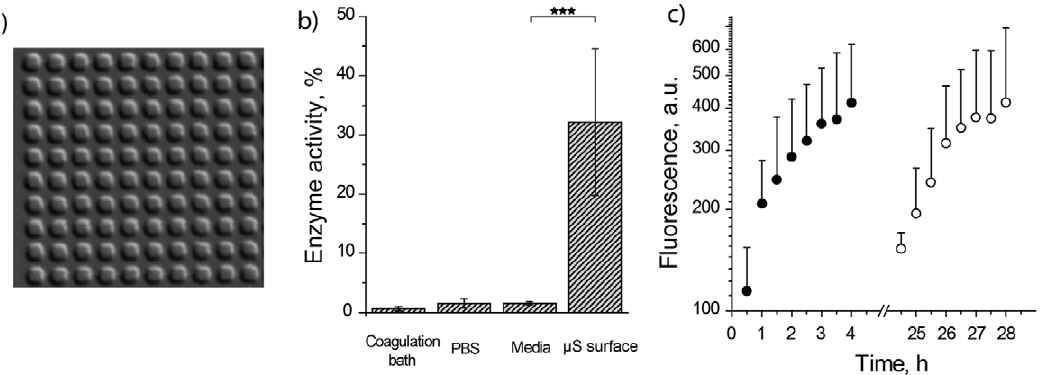
Figure 2. Visualization and initial characterization of m S PVA hydrogels as matrices for SMEPT. (a) Differential interference contrast microscopy image of the surface adhered m S PVA hydrogels (2 m m cubic structures). (b) Levels of b -Glu enzymatic activity revealed by polymer coagulation bath, PBS washing solution, cell culture media washing solution, and final surface adhered m S PVA hydrogels. Enzyme quantification was performed using FdG, 30 min reaction time and a standard curve obtained for the activity of b -Glu in PBS. (C) Experimental data for conversion of FdG into fluorescent product using m S PVA hydrogels and initiating conversion via administration of FdG at time points t=0 (solid circles) and t=24 h (open circles). Experimental conditions: [FdG]: 2,5 m g/mL; 1 g/L b -Glu in the polymer solution used for the production of